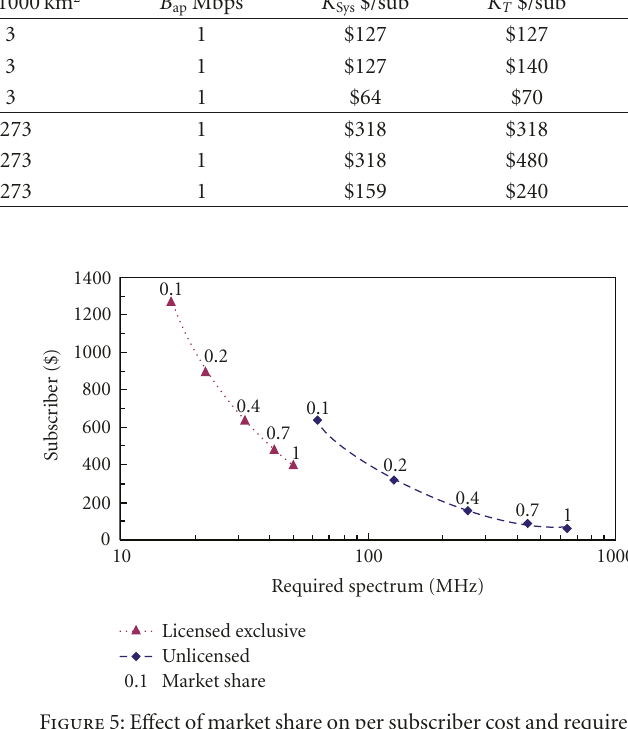
Figure 5: E ff ect of market share on per subscriber cost and required spectrum in the urban